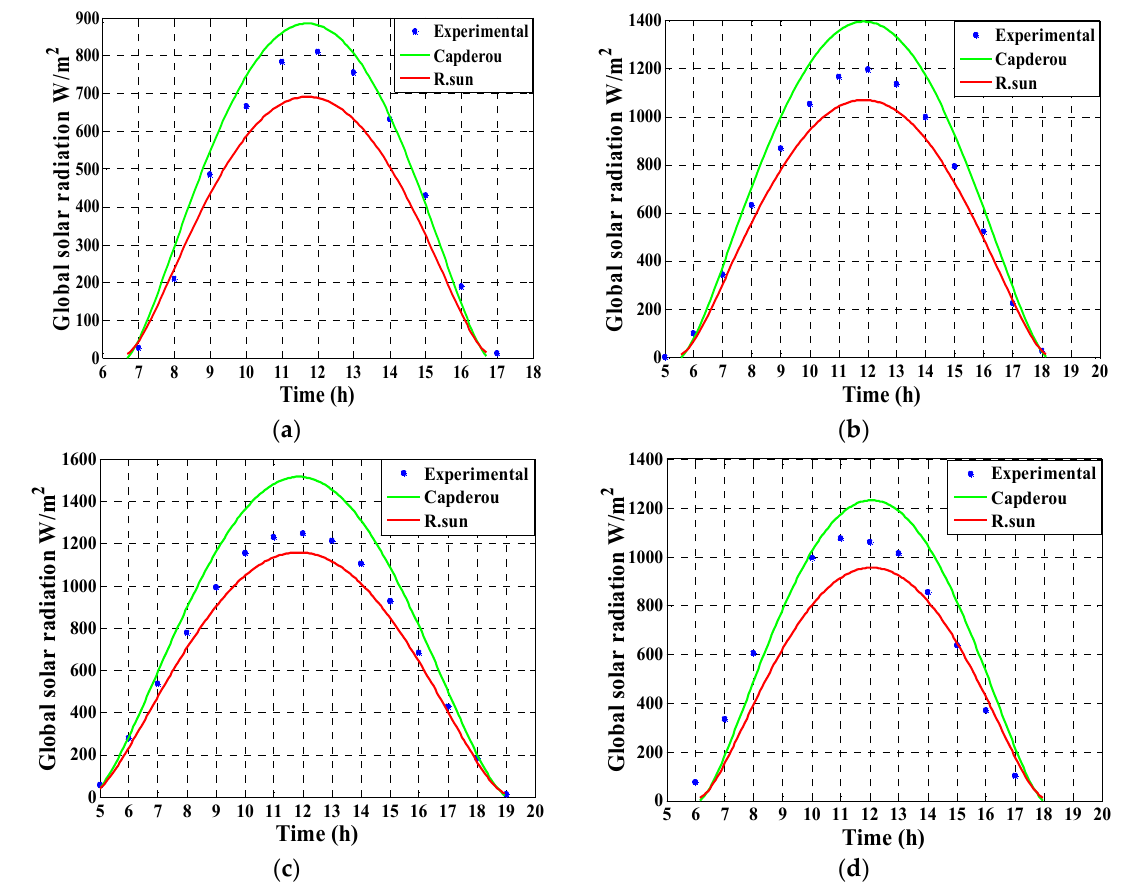
Figure 10. The comparison between the measured global solar radiations and the global solar radiation obtained by Capderou and R.Sun models for the site of Tlemcen. ( a ) 22 January 2006; ( b ) 8 April 2006; ( c ) 29 June 2006; ( d ) 26 September